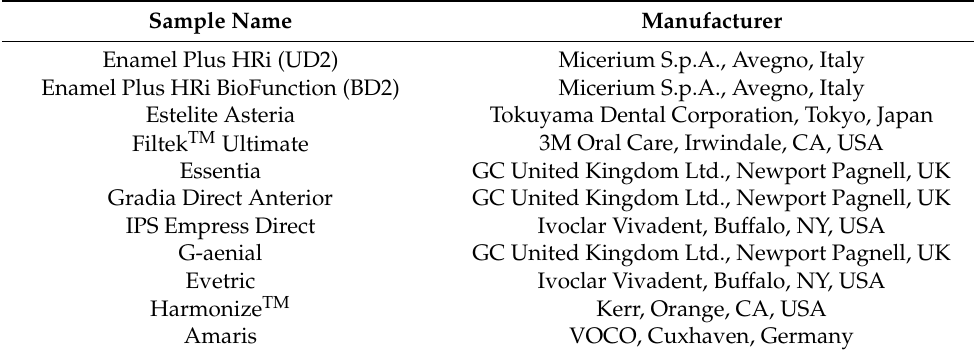
Table 1. The dental resins used in this